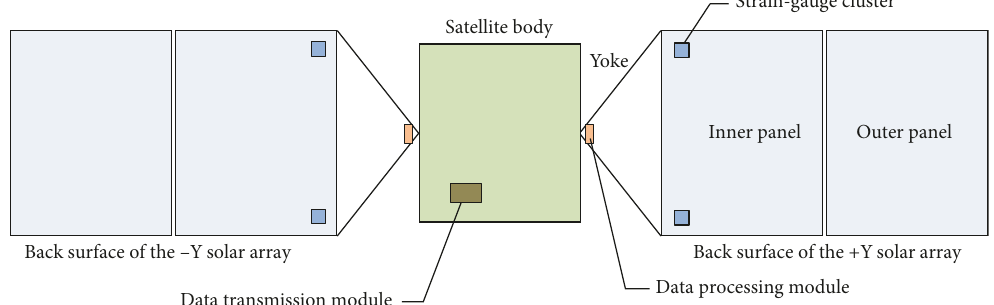
Figure 4: Mounting positions of the strain measurement apparatuses.